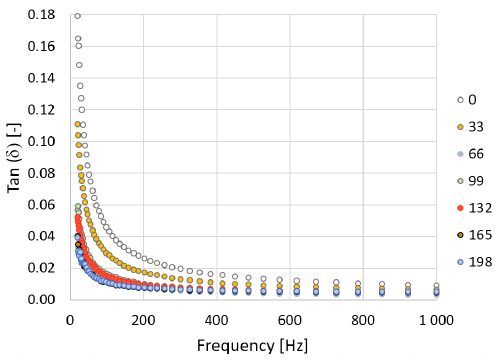
Figure 8. V-TPE-E—measurement course of the loss factor in dependence on frequency.